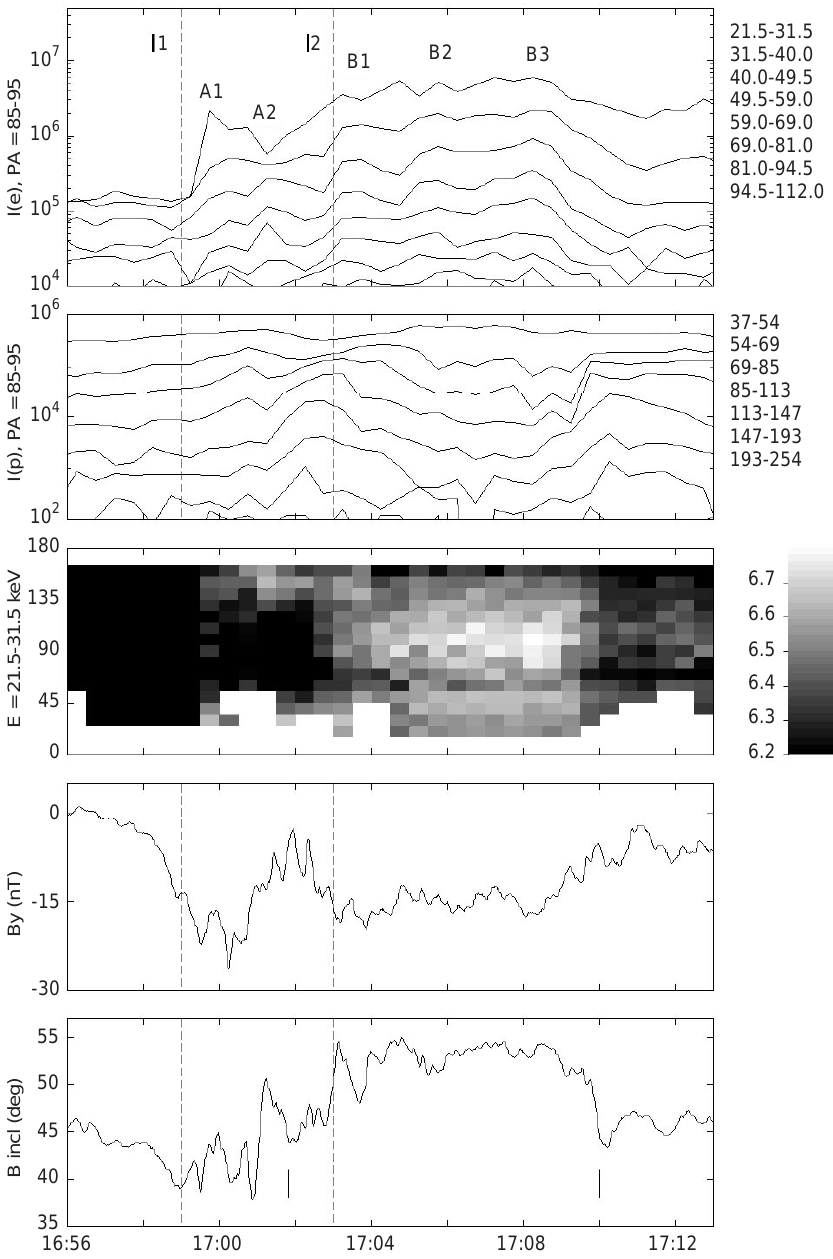
Fig. 4. The first two intensifications (about 1659–1702 UT and 1703–1710 UT, respec- tively). Shown are equatorial (90 (cid:14) PA) electron (cid:133) panel 1 (cid:134) and proton (cid:133) panel 2 (cid:134) flux intensities at the lowermost energy chan- nels, electron PAD at 21.5–31.5 keV (cid:133) panel 3 (cid:134) , B y (cid:133) panel 4 (cid:134) ; and inclination of B (angle between B x and B z ; panel 5 (cid:134) : Flux intensities are expressed in cm (cid:255) 2 s (cid:255) 1 sr (cid:255) 1 keV (cid:255) 1 : The vertical tick marks in the lowermost panel indicate the intervals of increased field line stretching that coincide with the proton